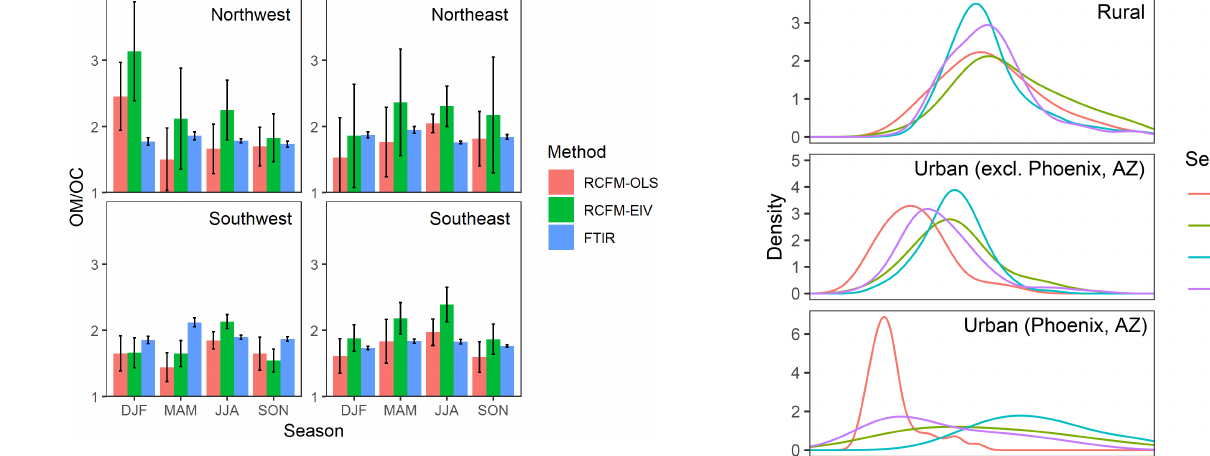
Figure 8. Estimates of OM / OC with 95 % confidence interval made by different techniques for the same sites for which FTIR measurements are available (Sect. 2). OLS (ordinary least squares) and EIV (error-in-variables) provide solutions to RCFM regression, and FTIR estimates are constructed from contributing functional groups. The x axes denote seasons: DJF (December, January, Febru- ary) is winter, MAM (March, April, May) is spring, JJA (June, July, August) is summer, and SON (September, October, November) is fall.